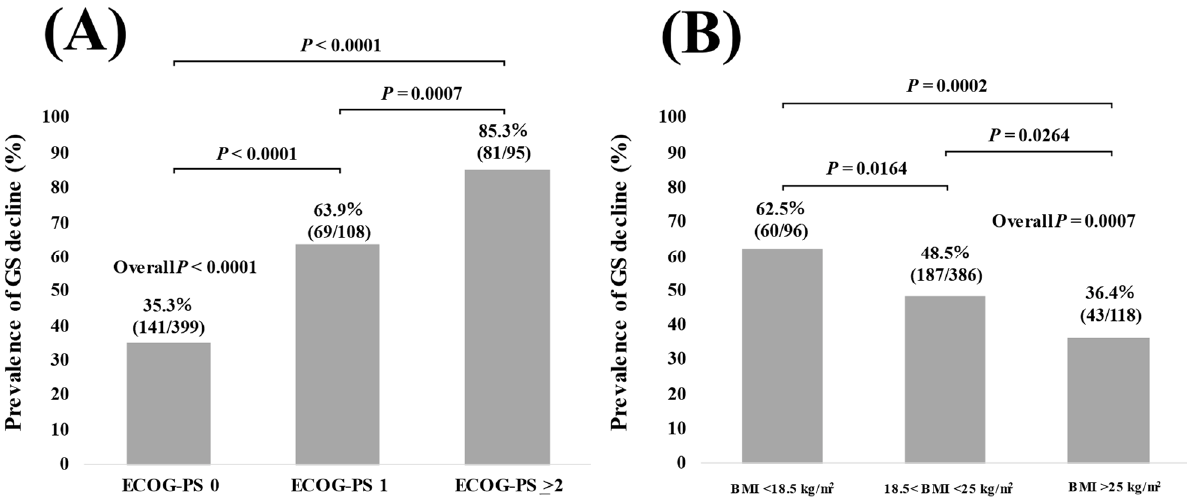
Figure 1. ( A ) The percentage of GS decline in patients with ECOG-PS 0 ( n = 399), ECOG-PS 1 ( n = 108), and ECOG-PS 2 ( n = 95). ( B ) The percentage of GS decline in patients with BMI (kg/m 2 ) < 18.5 ( n = 96), 18.5 < BMI (kg/m 2 ) < 25 ( n = 386), and BMI (kg/m 2 ) > 25 ( n = 118).